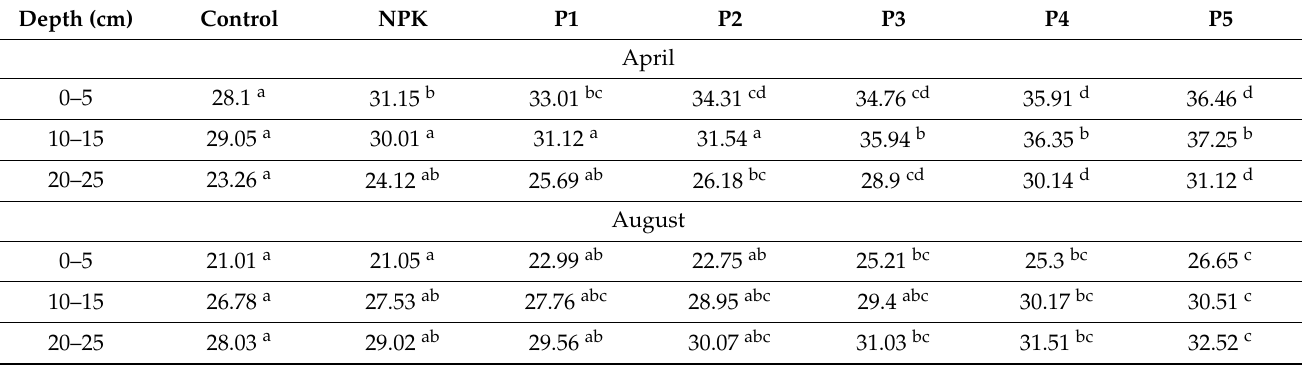
Table 2. Podzolic soil—Moisture v / v %. Control (without fertilization), NPK K 2 O in mineral